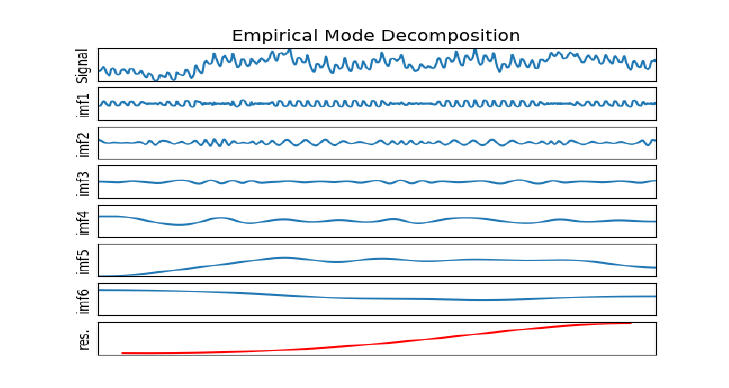
Figure 1. Example of one month load decomposition in a public utility sector in the